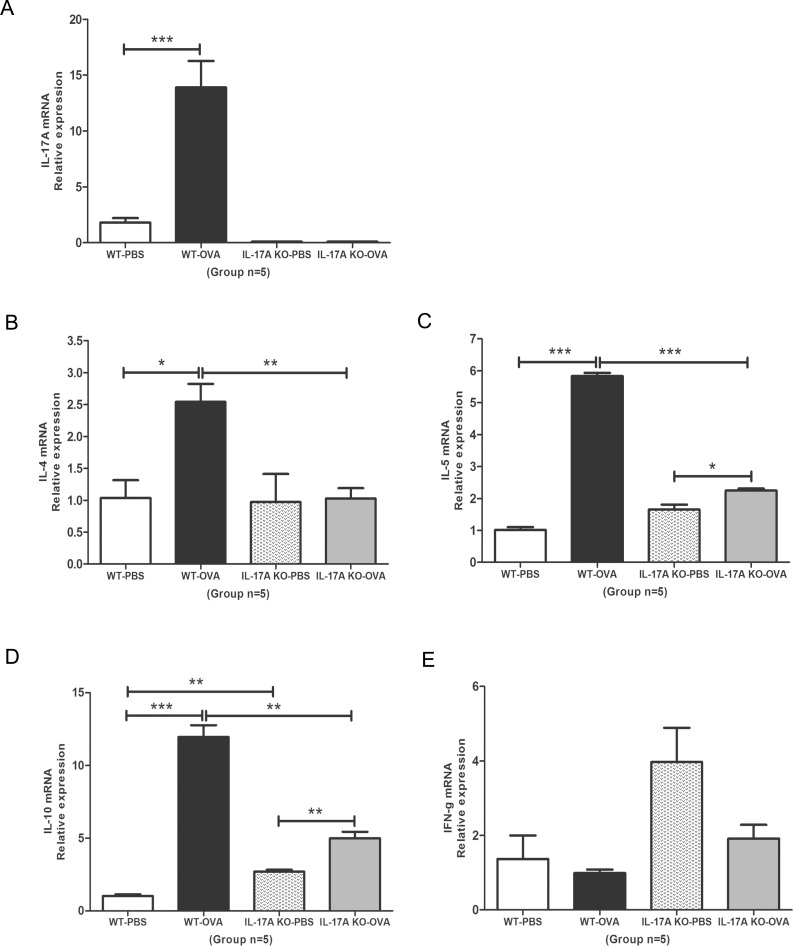
Comparison of the following cytokine mRNA levels in the nasal mucosa.(A) interleukin (IL)17A, (B) IL-4, (C) IL-5, (D) IL-10, and (E) interferon (IFN)-γ. mRNA levels of the target genes were normalized to those of glyceraldehyde 3-phosphate dehydrogenase and expressed as fold changes relative to the WT-phosphate-buffered saline group. Results are means ± SEM (n = 5). (*** P < 0.001, ** P < 0.01, * P < 0.05). Figures are representative results from at least two independent experiments.